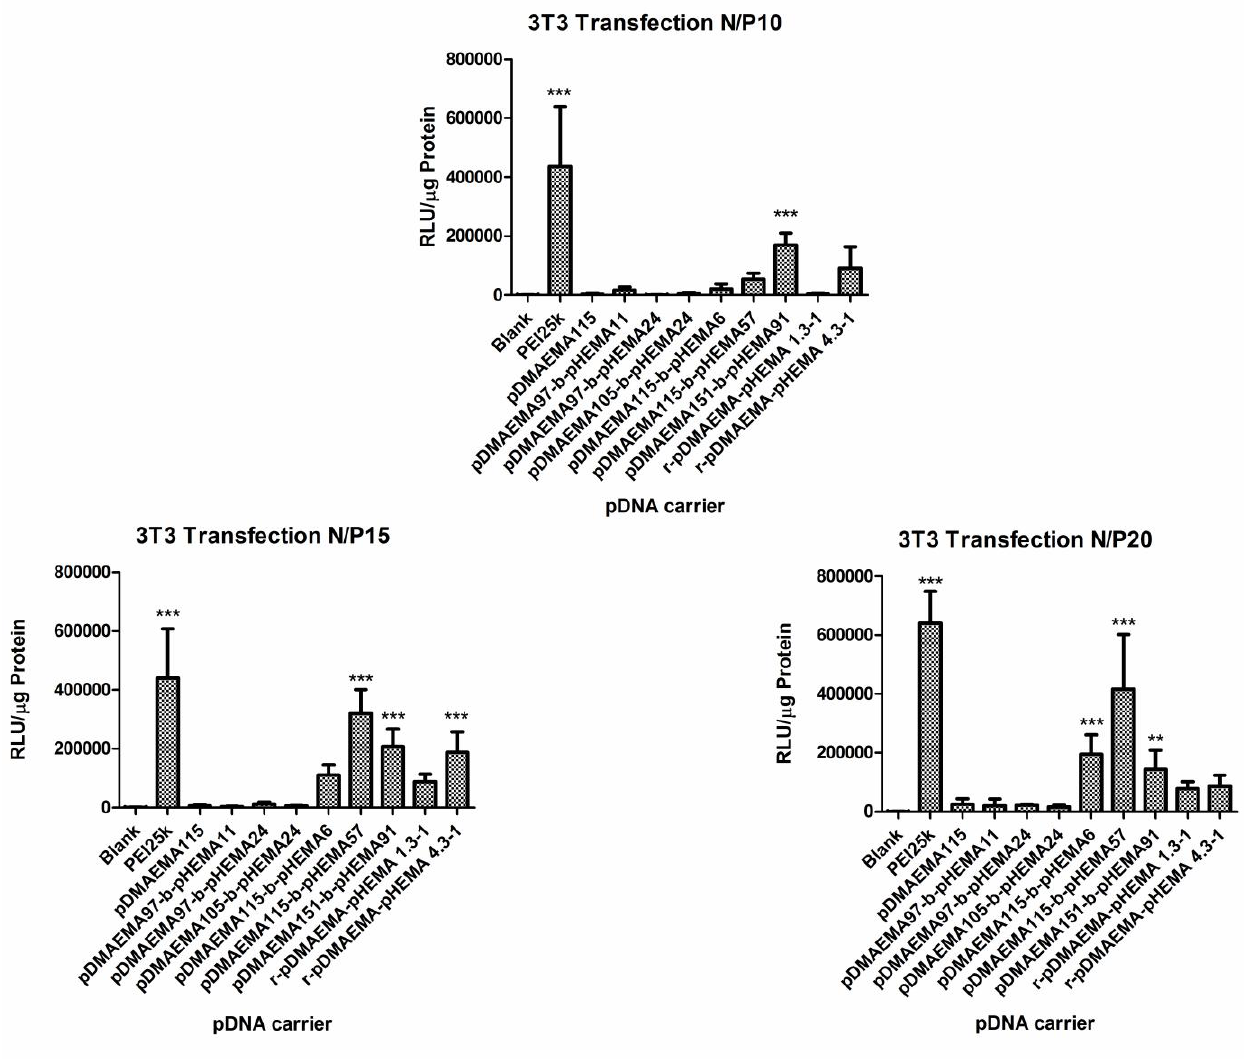
Figure 11. Transfection efficacy of copolymers in 3T3 mouse fibroblasts,